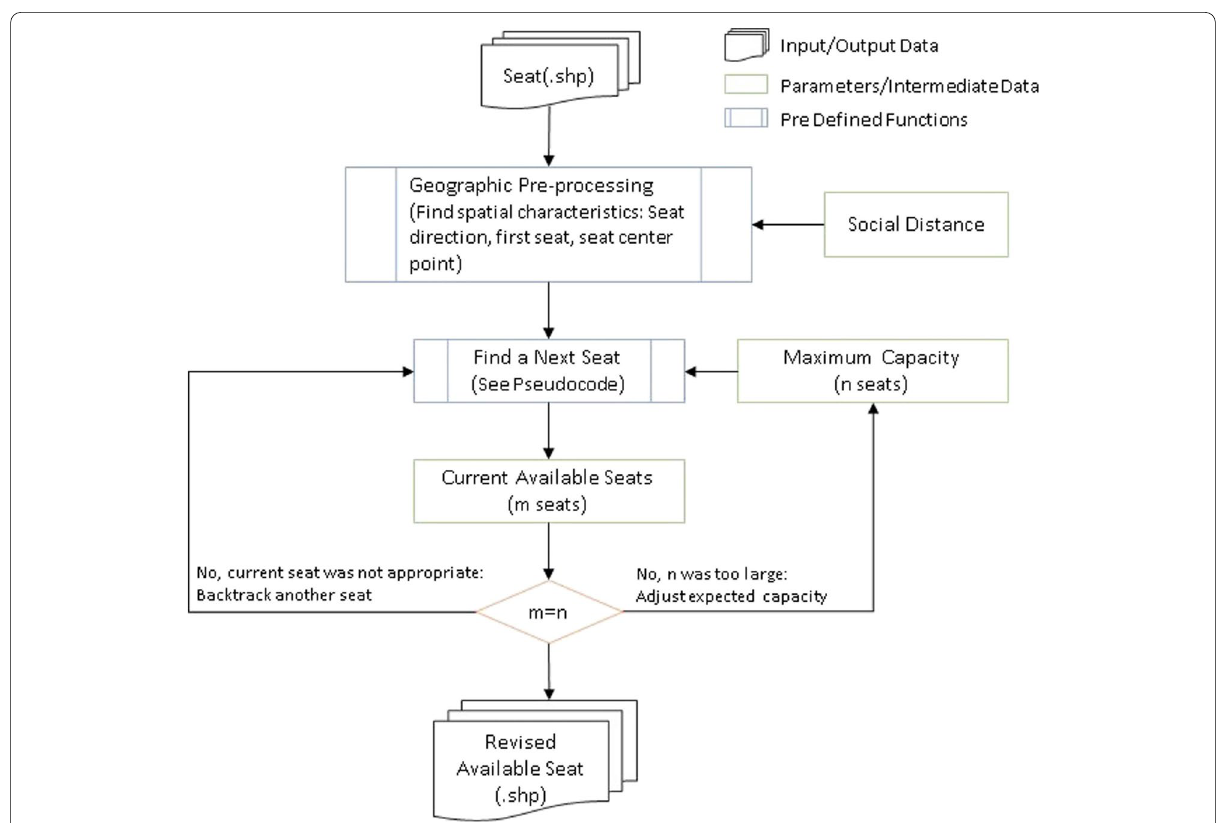
Fig. 2 The flowchart of fixed model backtracking